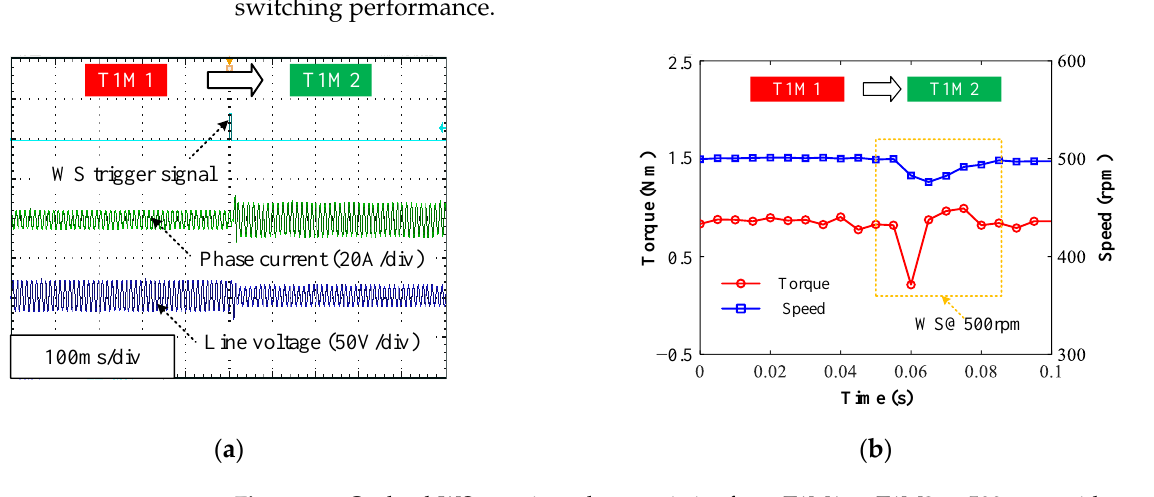
Figure 12. On-load WS transient characteristics from T1M1 to T1M2 at 500 rpm with a constant torque of 0.8 Nm. ( a ) Line voltage and phase current waveforms. ( b ) Torque and speed curves.